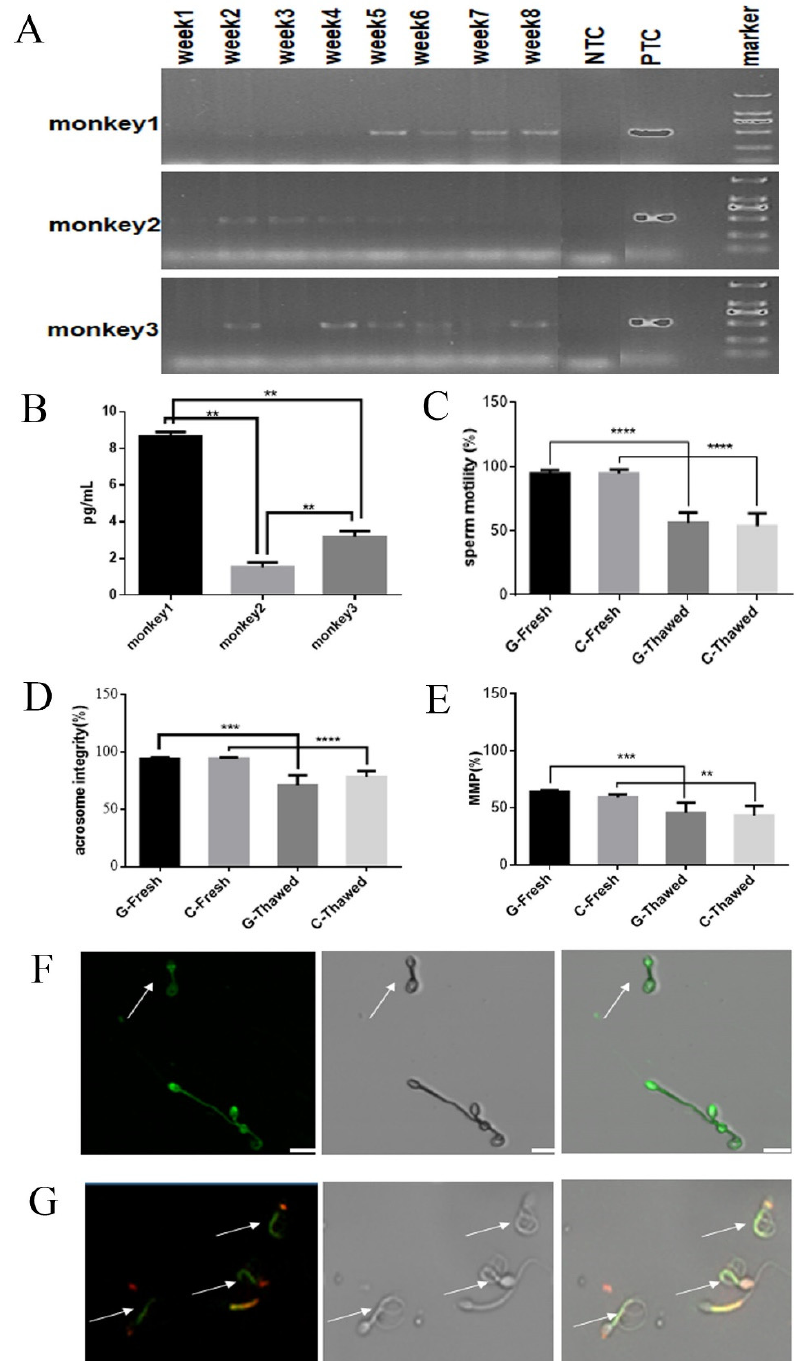
Figure 4. Validation of transgenic sperm and sperm evaluation before and after freezing: ( A ) PCR detection of EGFP integration: week1–week8 refer to weekly sperm collection after two months of EGFP lentivirus injection. NTC: Water replaced the sperm sample as a negative control; PTC: EGFP lentivirus replaced the sperm sample as a positive control. ( B ) q-PCR: The amount of EGFP integration in the genome; the bar chart represents the amount of EGFP expression in the 3 monkey sperms transducted with EGFP lentivirus relative to the control group. ( C ) Evaluation of sperm motility with transgenic sperm carrying EGFP gene. Eight semen samples collected from each of the three male monkeys were performed for cryopreservation and evaluation. ( D ) Evaluation of acrosome integrity. ( E ) Evaluation of mitochondrial membrane potential. ( F ) Frozen − thawed sperm cells with intact and reacted acrosomes; arrow indicates an acrosome damaged sperm. ( G ) The frozen–thawed sperm with intact and decreased mitochondria function, but no difference with normal frozen–